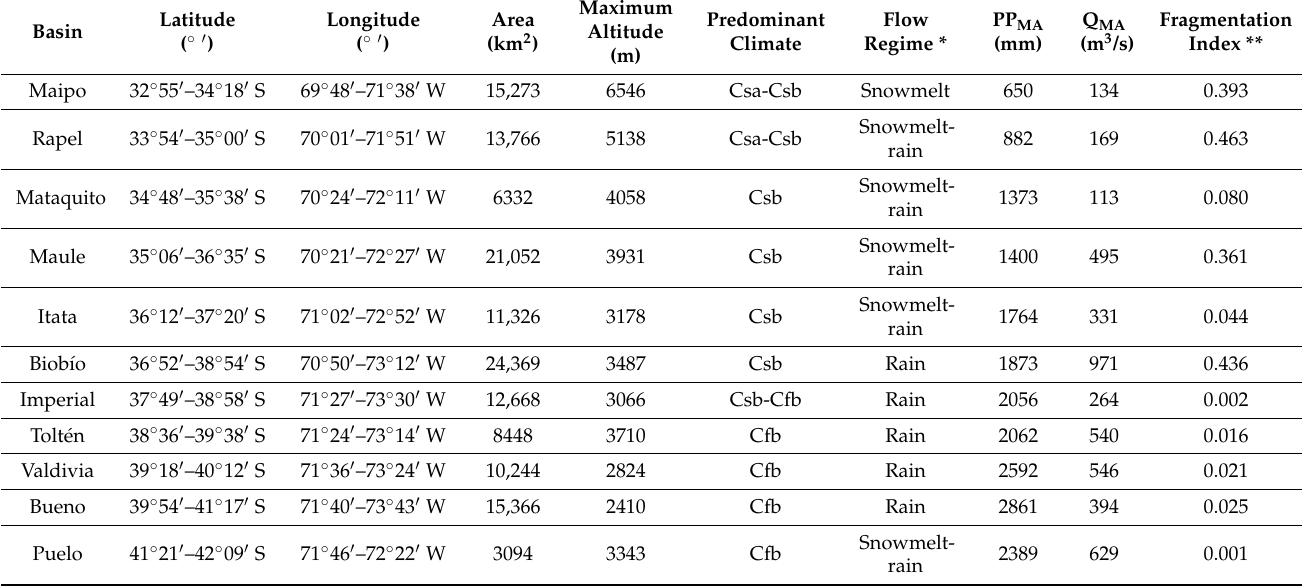
Table 1. Geographic position, catchment area, maximum altitude, climate, mean annual precipi- tation and mean annual discharge at the mouth of eleven studied river basins. Csa, hot-summer Mediterranean climate; Csb, warm-summer Mediterranean climate; Cfb, Oceanic climate (Marine west coast)